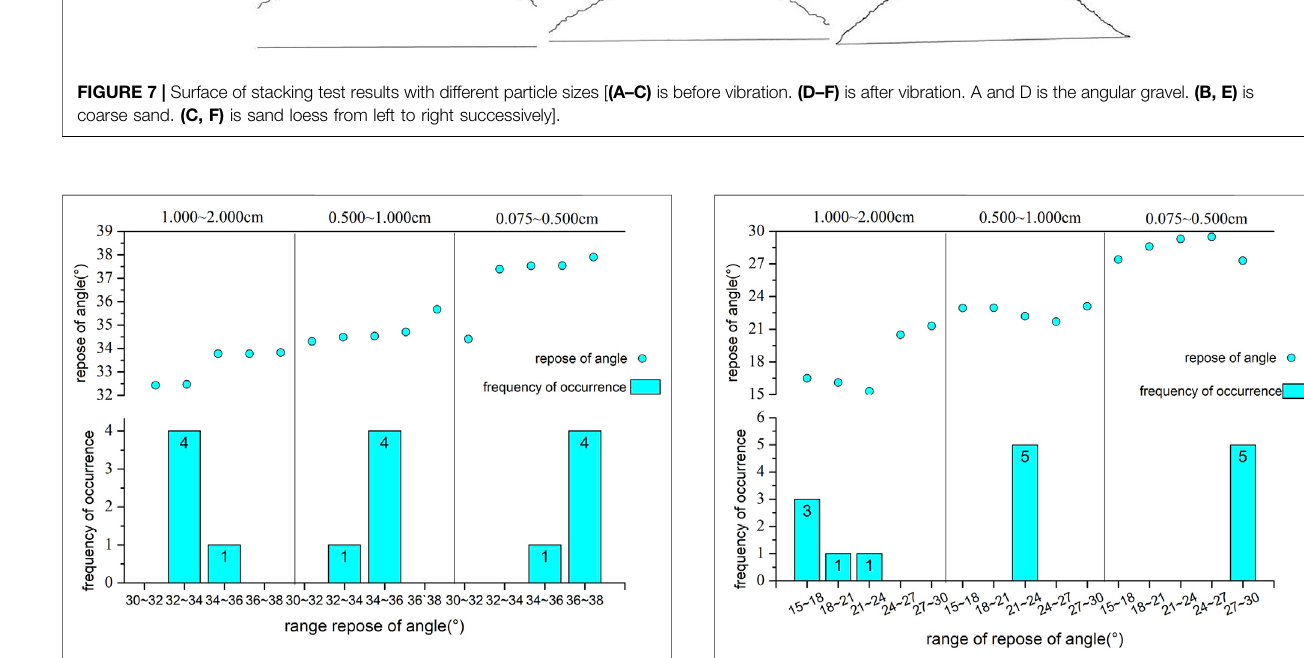
FIGURE 9 | Stacking test results and angle of repose distribution under